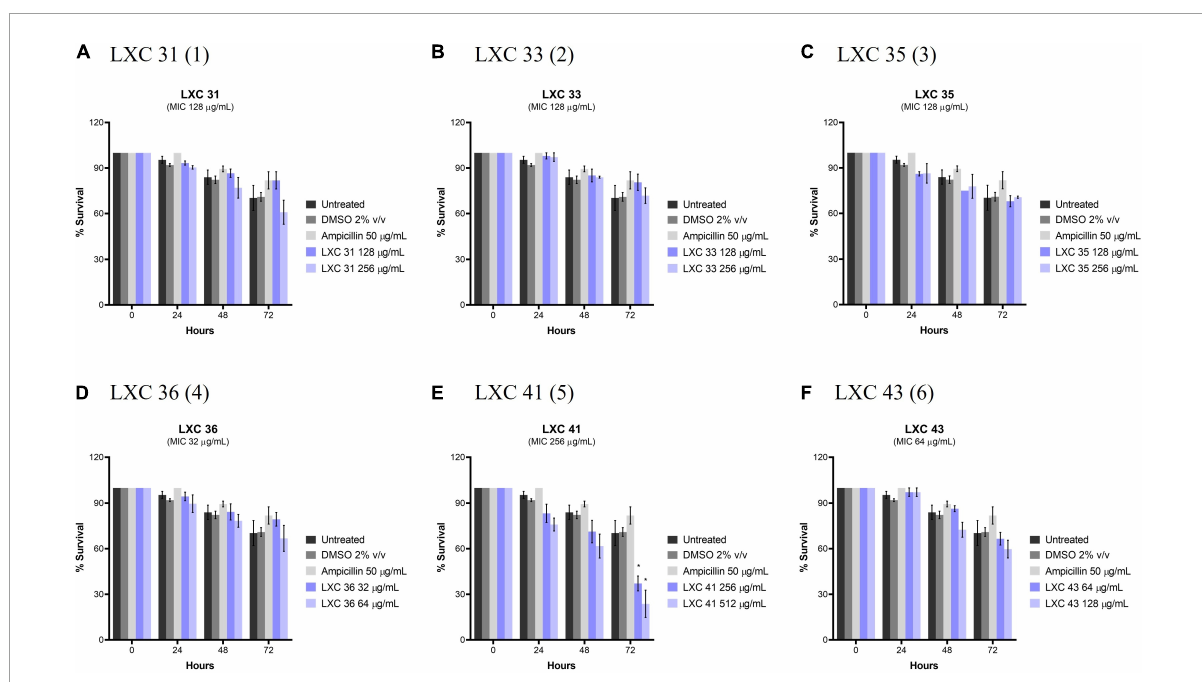
FIGURE10 The LXC compounds (apart from compound 5 ) were not cytotoxic to C. elegans nematodes. (A–F) C. elegans nematodes were cultured on nematode growth media agar plate and harvested in optimized growth media, with E. coli as its primary source of nutrient. Newly harvested adult nematodes were investigated for toxicity in the presence of the LXC compounds at 1 × and 2 × their MIC values for a timespan of up to 72 h. The nematodes were counted under a light microscope at 400 × magnification and the live nematodes at 72 h was indicated as a fraction of the starting number of nematodes (percentage survival). The results are presented in mean percentage of survival ± SEM. Statistical analysis was performed using two-way ANOVA and the asterisks (*) represent statistical significance: LXC 41 ( 5 ) at time 72 h (* p <